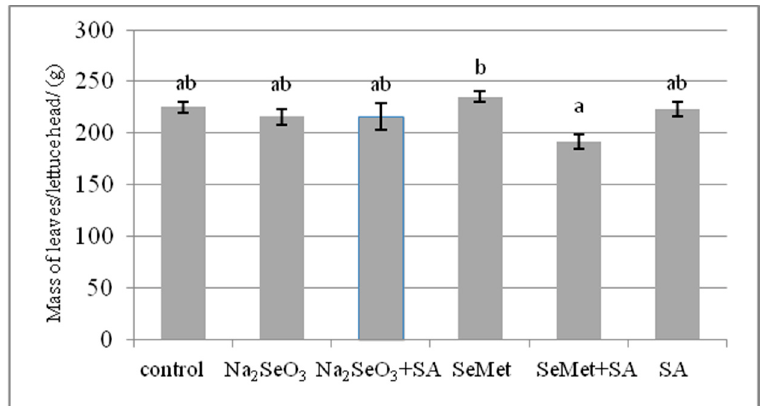
Figure 1. Yield—mass of a single lettuce head. Means followed by different letters indicate significant differences ( p < 0.05). The bars indicate standard error (n = 4).